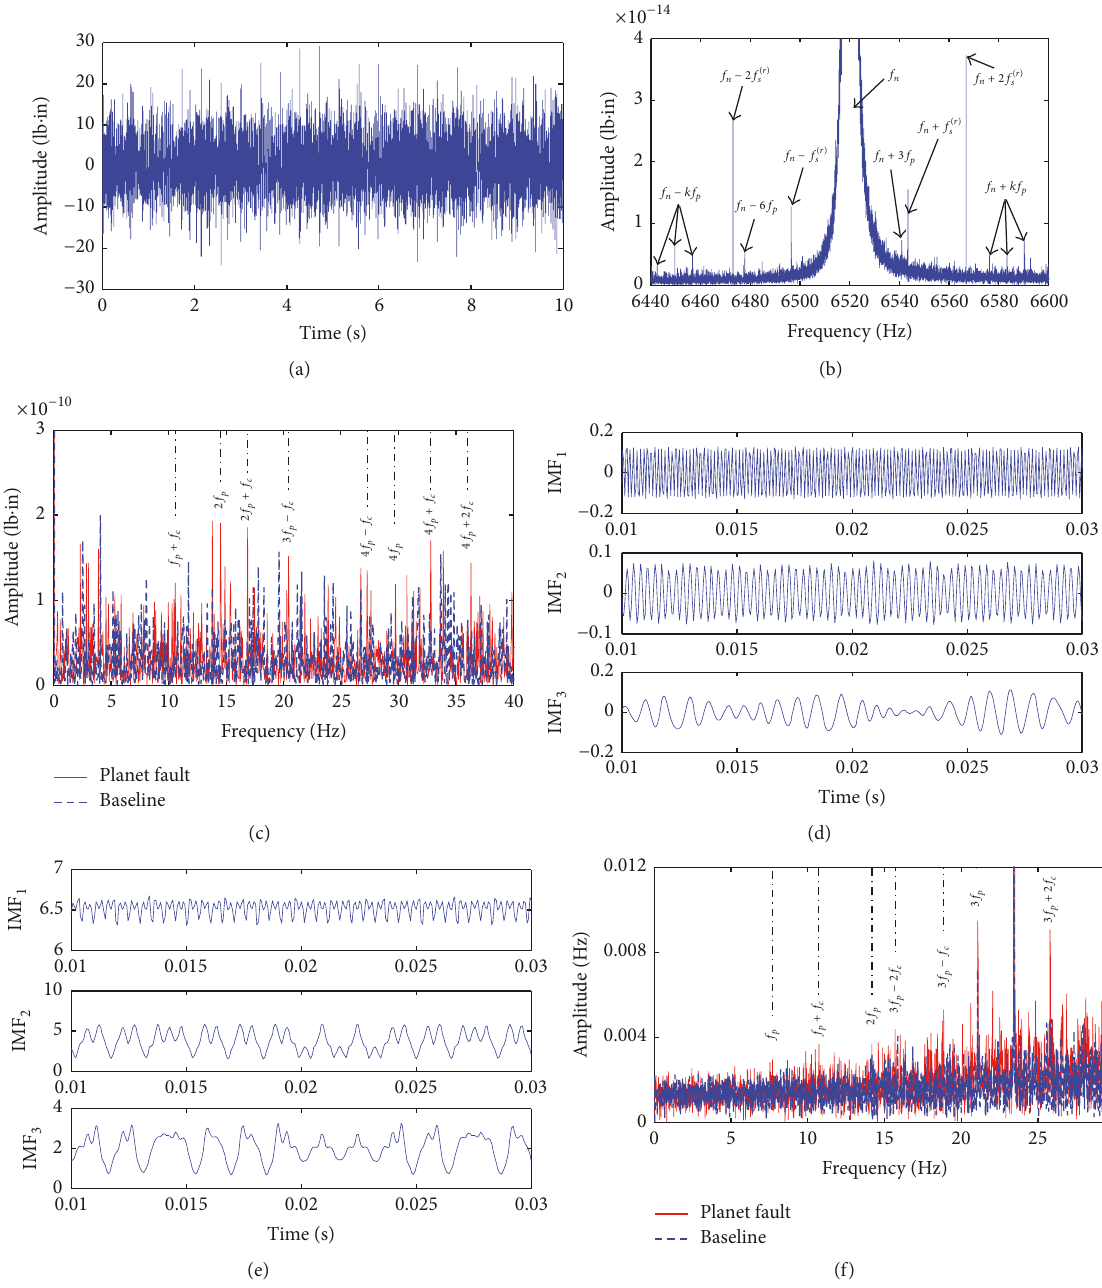
analysis of torsional vibration signal during a speed-up process; see Figure 14(c).